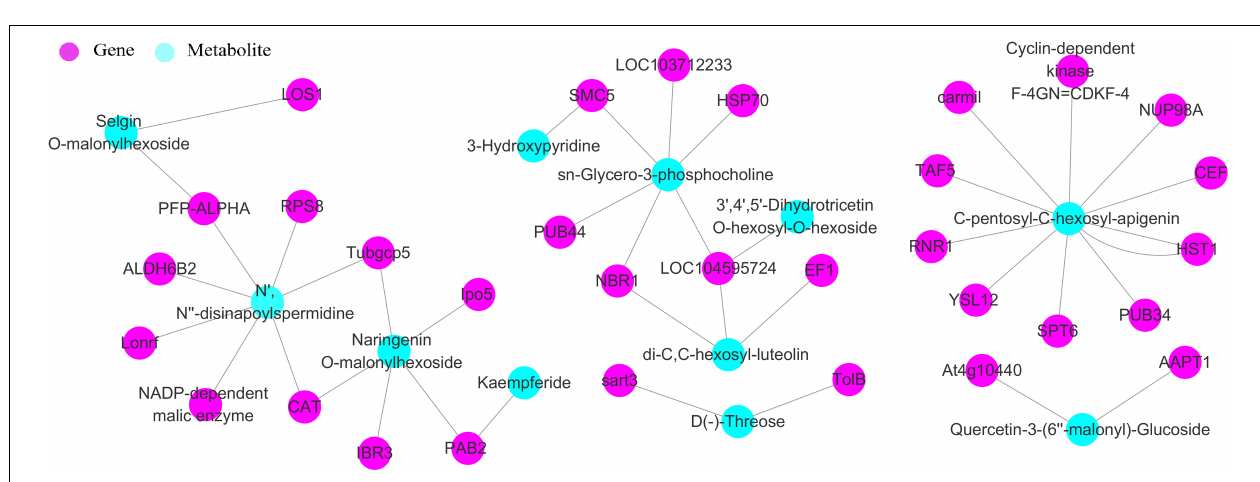
FIGURE 6 | Coexpression network of DEGs and differentially expressed metabolites. These DEGs were correlated with metabolites ( R > 0.8). The networks were visualized with the Cytoscape software. The purple denotes represent DEGs, and blue means differential metabolites.